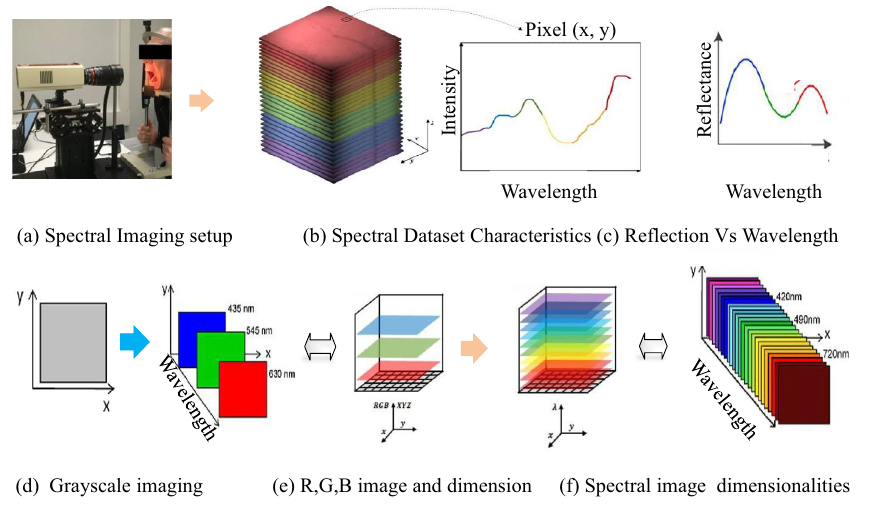
Figure 9. The Spectral imaging setup to characterize the wavelength and reflection distribution, with respect to the color imaging channels and spectral dimensionalities of the